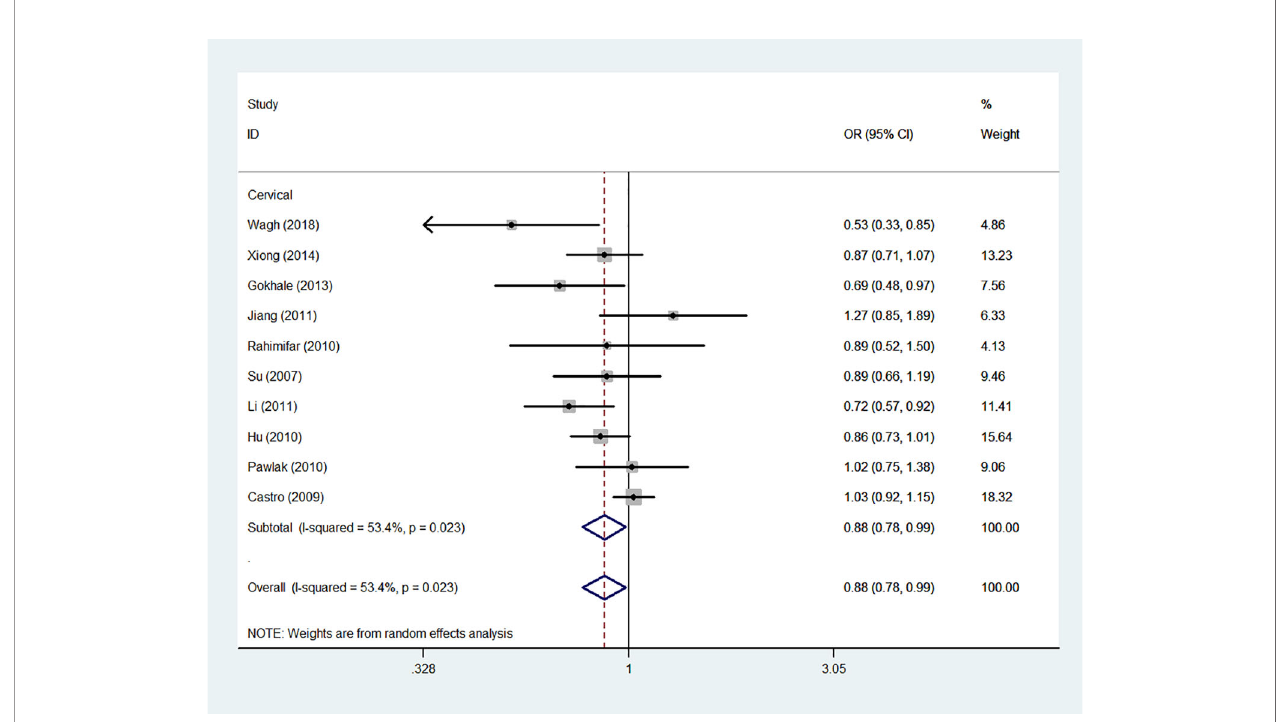
FIGURE 6 | Forest plot of the association between the CTLA-4 gene rs231775 polymorphism and cervical cancer risk (G-allele vs. A-allele).